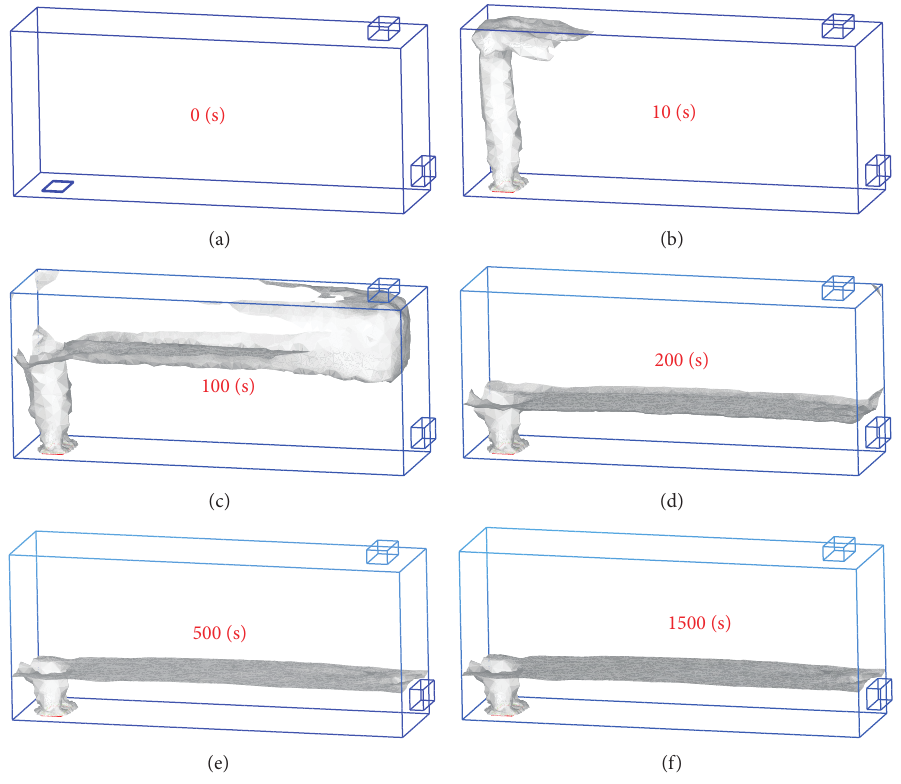
Figure 6: The isosurface of volumetric concentration at